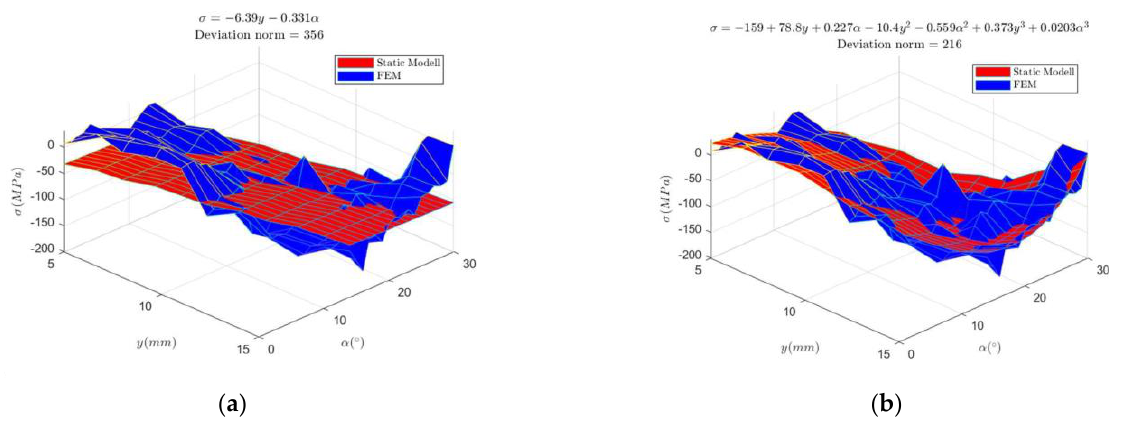
Figure 6. ( a ) Linear approach and ( b ) cubic approach for the residual stresses.